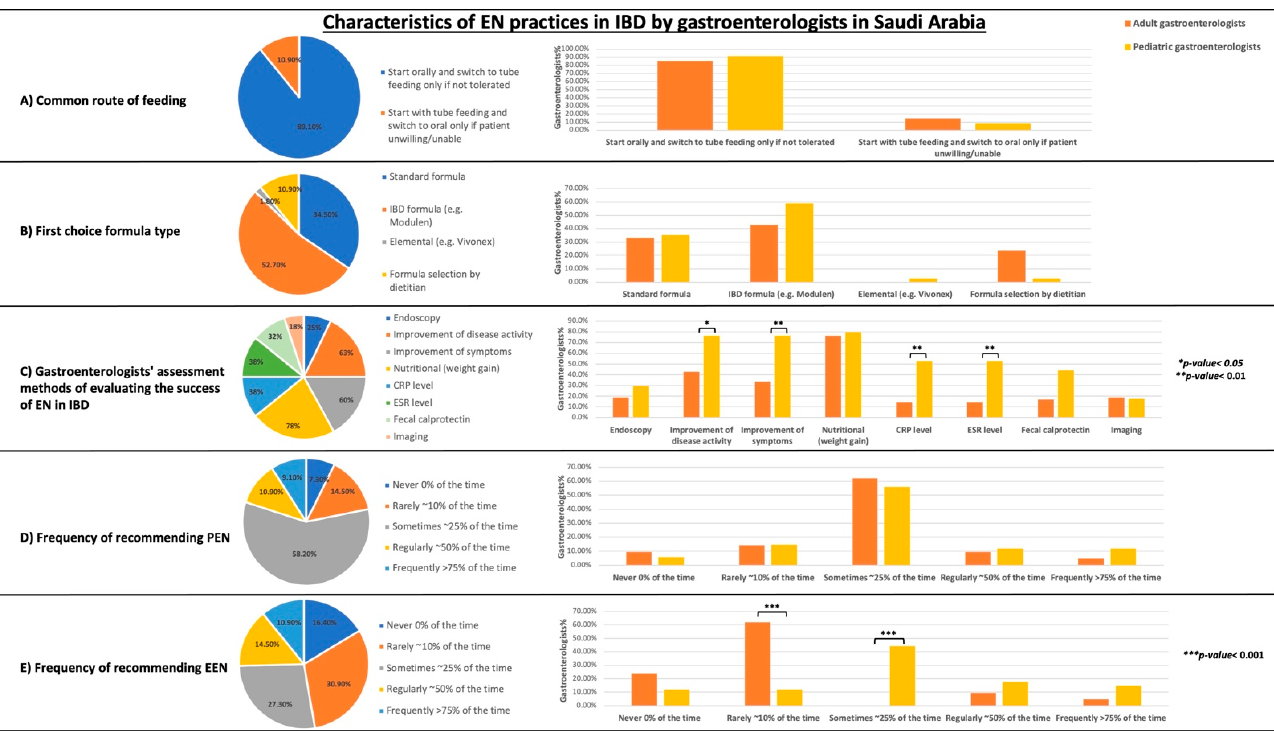
Figure 2. Characteristics of practicing EN in any form. Results are presented in percentages. All gastroenterologists ( n = 55), adults ( n = 21), pediatric ( n = 34). ( A ) Common routes of EN feeding. ( B ) First choice formula type. ( C ) Methods of evaluating EN treatment success in IBD (total percentages do not add up to be 100% because this is a multiple response variable). ( D ) Frequency of partial enteral nutrition (PEN) practice. ( E ) Frequency of exclusive enteral nutrition (EEN) practice. p